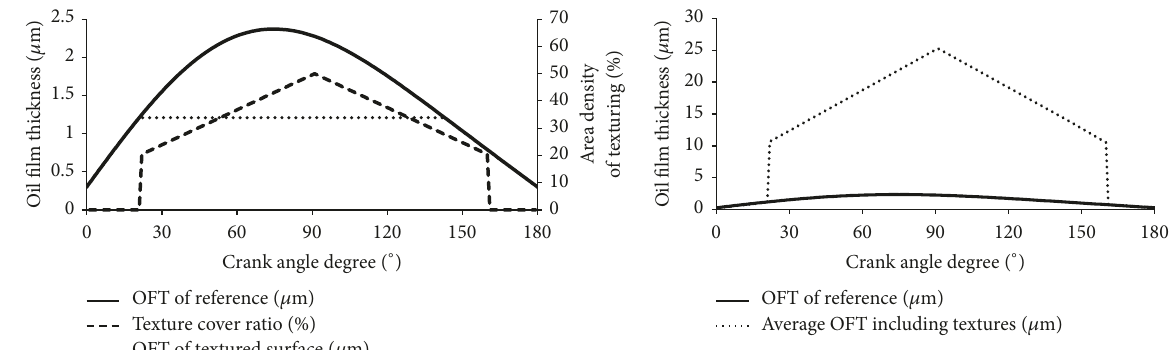
Figure 15: Tentative example of the oil film thickness with textured cylinder liner